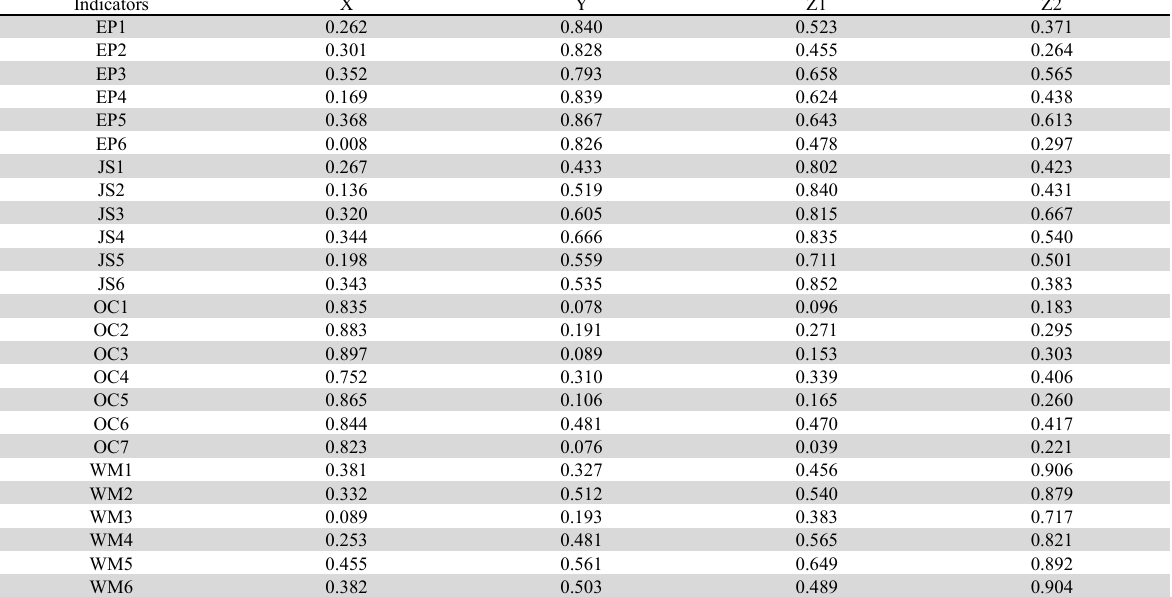
Result for Cross Loading Indicators